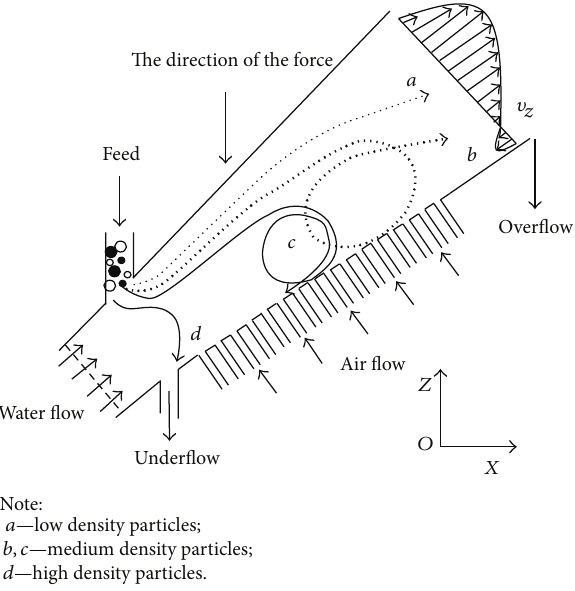
Figure 4: Movement trajectories of different